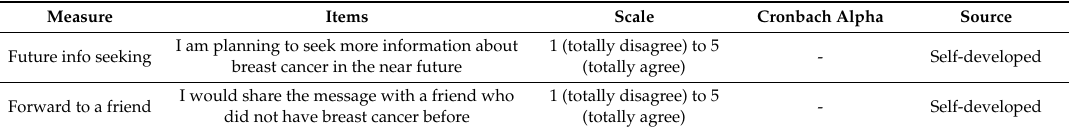
Table A1. Measures and